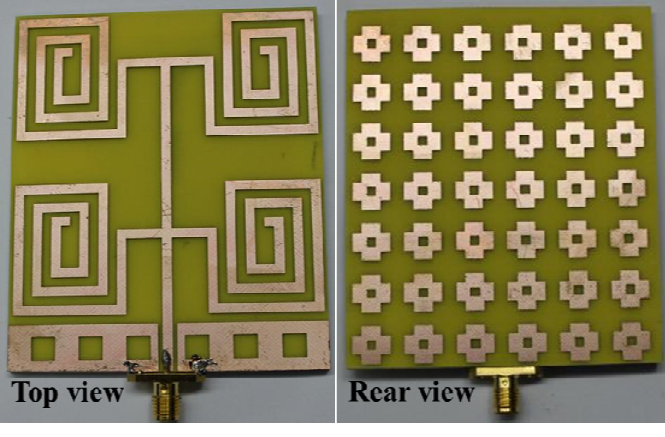
Figure 4. Photograph of the proposed NZRI MSS-backed antenna prototype.